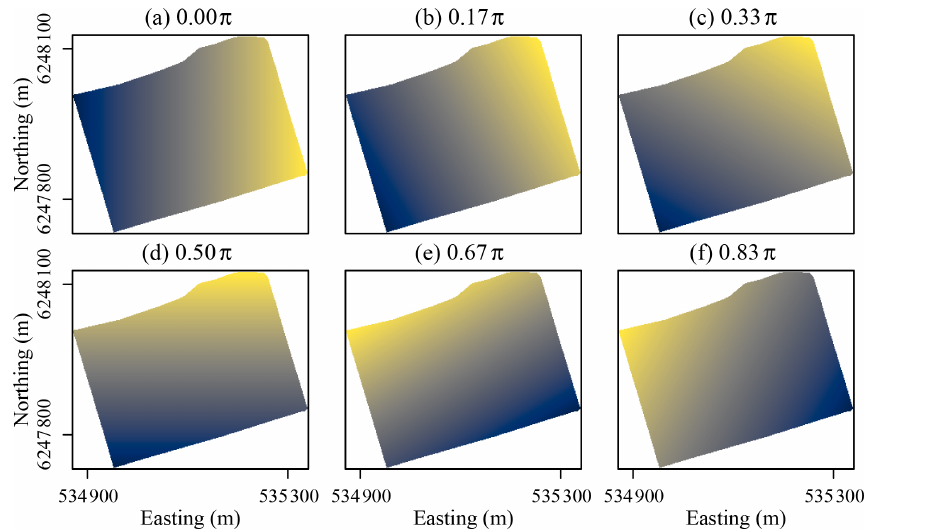
Figure 3. Examples of rasters with coordinates tilted at six different angles for the Vindum study area. Easting and northing for the Universal Transverse Mercator (UTM) zone 32N